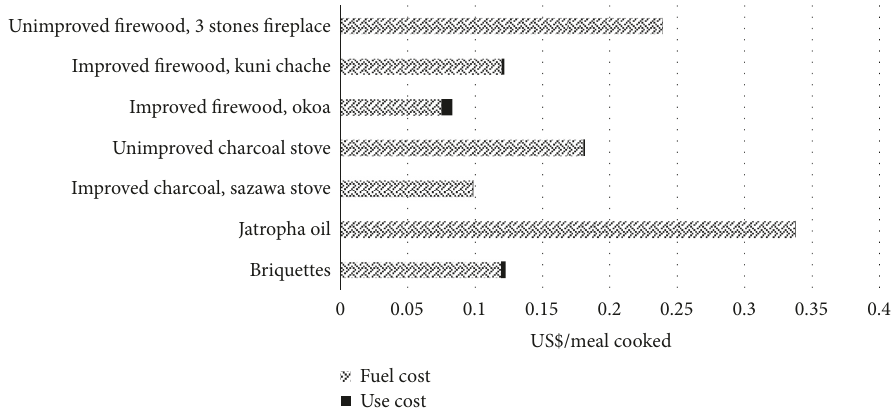
Figure 4: Life cycle costs per meal cooked (US$) for the different energy value chains in urban